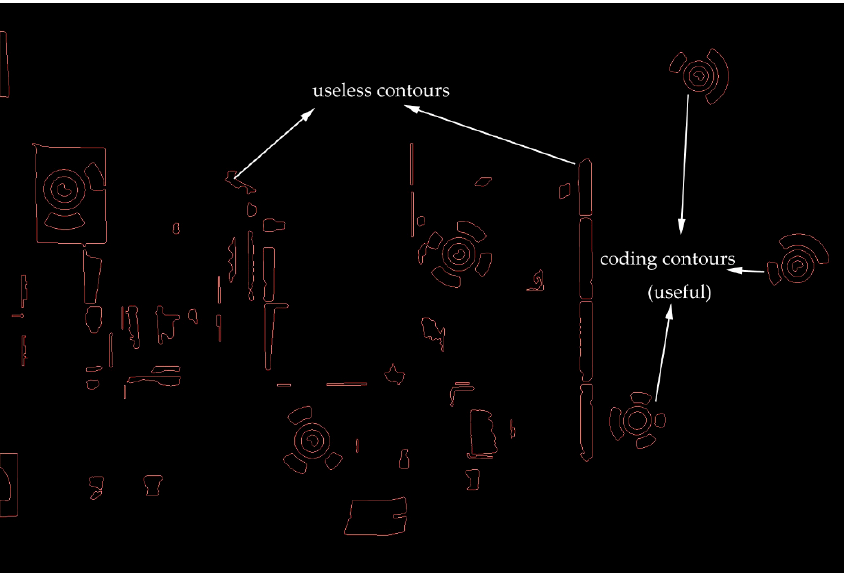
Figure 5. Contour Matching Results.